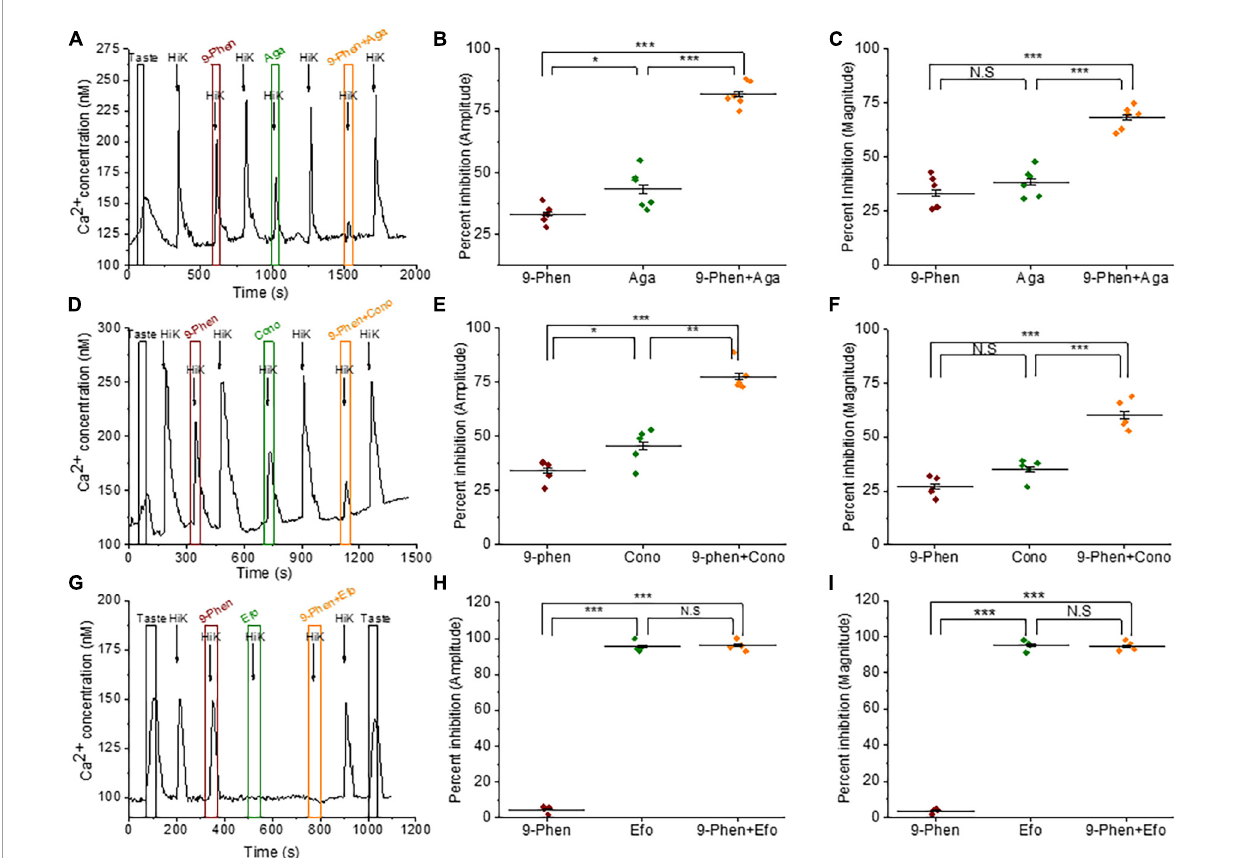
FIGURE3 TRPM4 does not contribute to calcium signals due to P/Q, N, and T-type VGCCs. (A) A representative calcium imaging trace showing inhibition of the 50 mM KCl responses by 9-phenanthrol (50 µ M), ω -agatoxin IVA (300 nM), and ω -agatoxin IVA + 9-phenanthrol in BR cells. Analysis of the 50 mM KCl signals revealed that co-application of ω -agatoxin IVA and 9-phenanthrol significantly increased the level of inhibition for both (B) signal amplitudes ( F ( 2 , 15 ) = 117.40, p = 0.00000000069) and (C) magnitudes ( F ( 2 , 15 ) = 50.68, p = 0.00000021) compared to inhibiting either channel alone ( n = 6 cells from 3 mice). (D) A representative calcium imaging trace showing inhibition of the 50 mM KCl responses by 9-phenanthrol, ω -conotoxin GVIA (800 nM), and ω -conotoxin GVIA + 9-phenanthrol in BR cells. The level of inhibition for both (E) the amplitudes ( F ( 2 , 12 ) = 56.10, p = 0.00000081) and (F) the magnitudes ( F ( 2 , 12 ) = 49.08, p = 0.0000017) of the responses significantly increased with the co-application of ω -conotoxin GVIA and 9-phenanthrol compared to the inhibition of either channel alone ( n = 5 cells from 3 mice). (G) A representative calcium imaging trace of the calcium responses to 30 mM KCl in BR cells. (H,I) This signal was not blocked by 9-phenanthrol, but was completely inhibited by ephonidipine (20 µ M), a T-type VGCC blocker in BR cells ( n = 4 cells from 3 mice) (* P < 0.05; ** P < 0.01; *** P < 0.001; N.S = Not